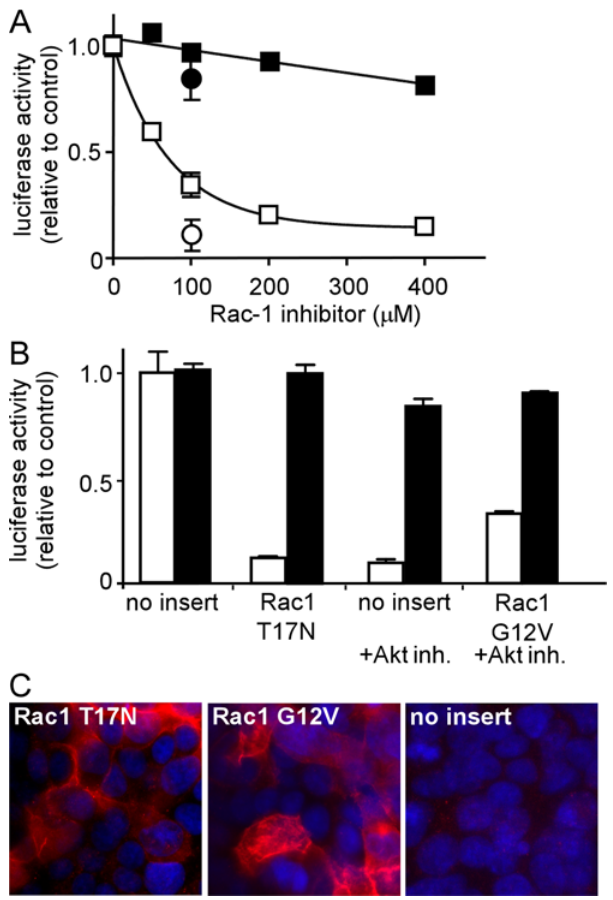
Figure 5. Rac1 plays a role in ZEBOV entry and serves as a downstream effector of Akt-1 signaling. (A) HEK293-mCAT-1 cells were treated with indicated concentrations of Rac1 inhibitor, and entry assays were performed using ZEBO-VLP (open squares), VSV-VLP (closed squares), EVP (open circles), or VSVP (closed circles). Data points represent the average 6 SD of 2 experiments. (B) HEK293-mCAT-1 cells were transfected with either pcDNA3 vector lacking insert, or pcDNA3 encoding dominant-negative Rac1 (Rac1-T17N) or pcDNA3 encoding constitutively active Rac1 (Rac1-G12V). Entry assays were performed 36 h later using ZEBO-VLPs (open bars) or VSV-VLP (solid bars) in the absence or presence of Akt inhibitor. Results are expressed as the percent of luciferase activity in untransfected cells. Each data point represents the mean 6 SD of 2 experiments. (C) Cells transfected with plasmids encoding HA-tagged Rac1-T17N (left panel), Rac1-G12V (middle panel), or empty vector (right panel) were stained using anti- HA mouse monoclonal antibody and Alexafluor 594 -conjugated anti- mouse IgG.